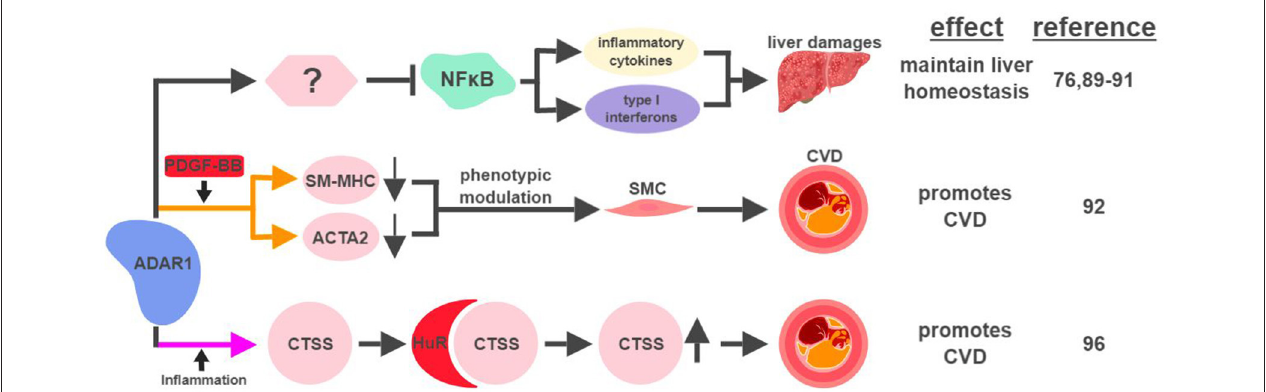
FIGURE 5 | ADAR1-mediated RNA editing in metabolic disorders. The color of the first arrow in each pathway indicates the mechanism (refer to Figure 1 ) by which ADAR1 regulates its direct targets, depicted in pink shapes. Additional activators of specific pathway steps are depicted in red rounded rectangles. Specific diseases and phenotypes/functions affected by ADAR1-mediated RNA editing are only labeled in the first appearance (ex. CVD). CVD, cardiovascular disease; SMC, smooth muscle cell. The figure was created with